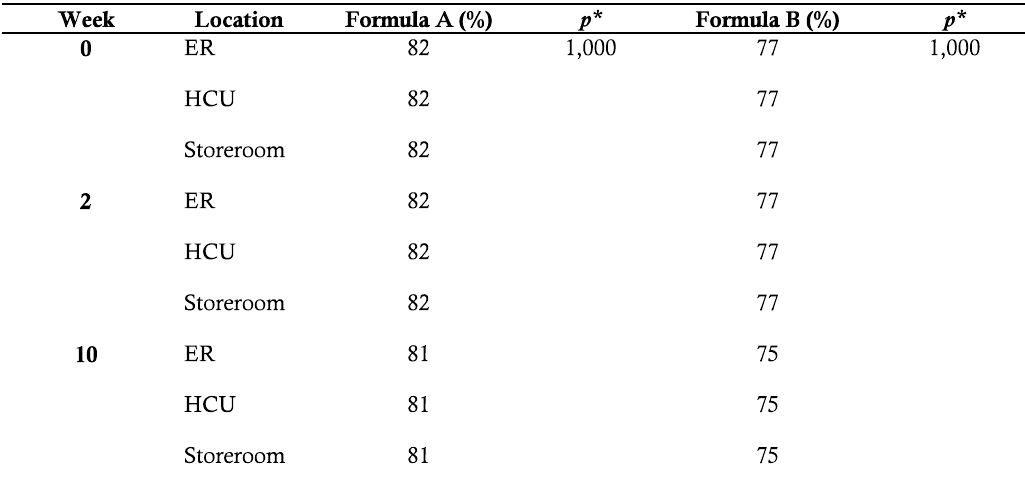
Table 3. Alcohol Levels of the WHO A and B Formulas